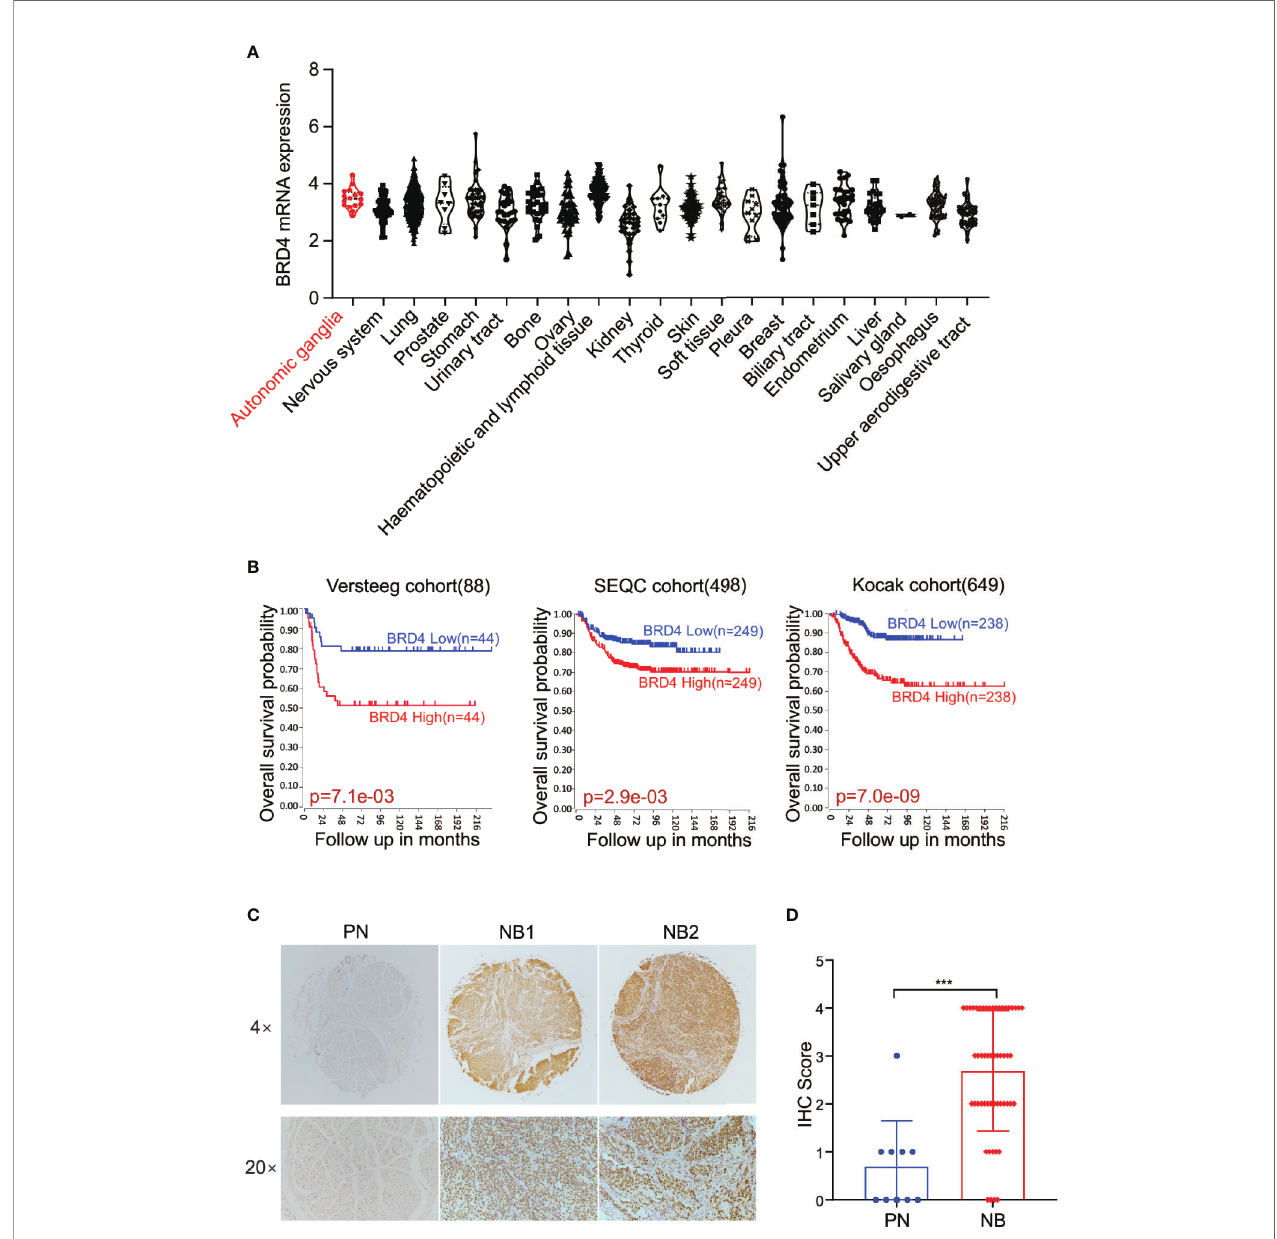
FIGURE 1 | BET proteins are universally expressed in NB cells. (A) BRD4 mRNA expression level in a broad range of tumors (generated from Broad Cancer Cell Line Encyclopedia: https://portals.broadinstitute.org/ccle). (B) Overall survival curve using public cohorts including 88 NB patients (left), 498 NB patients (middle), and 639 NB patients (right, 173 samples were omitted because of lack of survival data) generated from R2 Genomics Analysis and Visualization Platform (http://r2.amc.nl). Median survival time was used as a cutoff point for categorized as high or low expression. (C) Representative images of immunohistochemistry staining showed elevated BRD4 protein expression in NB patients ’ samples as compared to peripheral neuron. (D) Histologic scores were determined according to the intensity of BRD4 staining. *** p < 0.001. PN, peripheral neuron; NB,